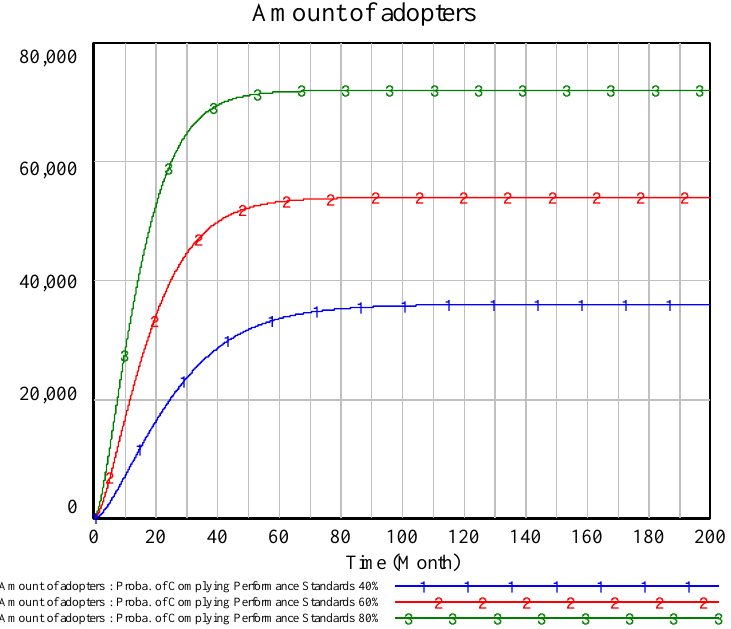
Figure 9. Sensitivity of probability of complying with performance standards on number of adopters.